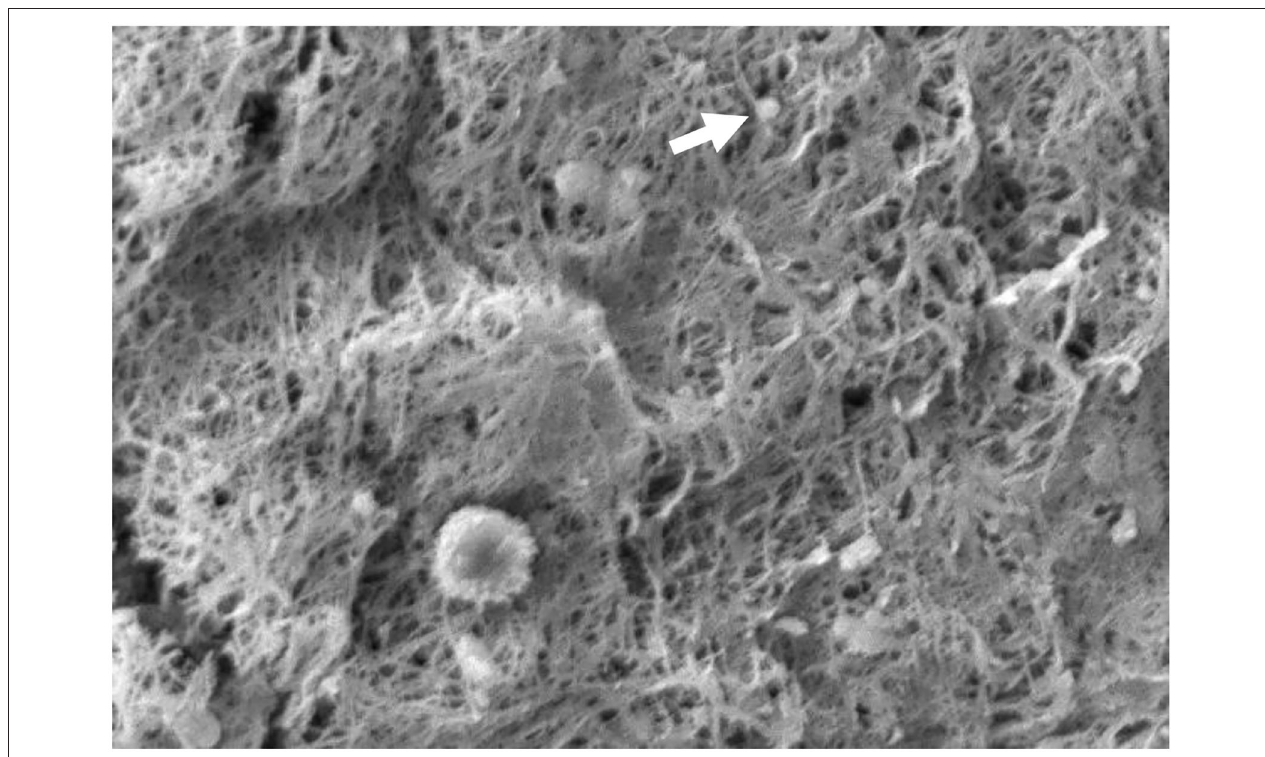
FIGURE 4 | The appearance of fibrin and platelet fibers on PRFM by SEM examination. The white arrows show the platelets between the fibrin fiber matrix. It appears that the fibrin fibers are evenly distributed like a mesh. 1,000 ×